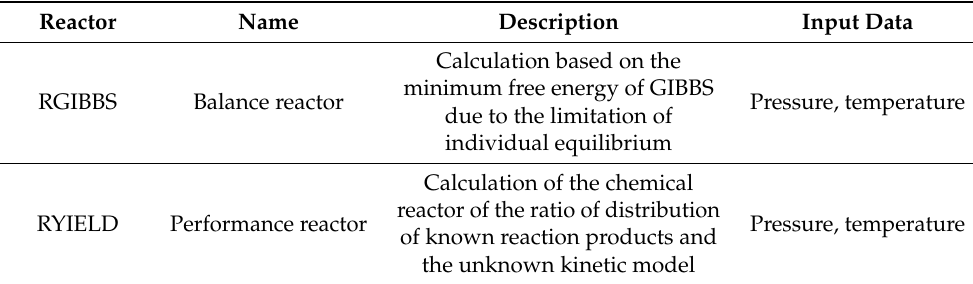
Table 4. Reactor models used in this simulation in Aspen